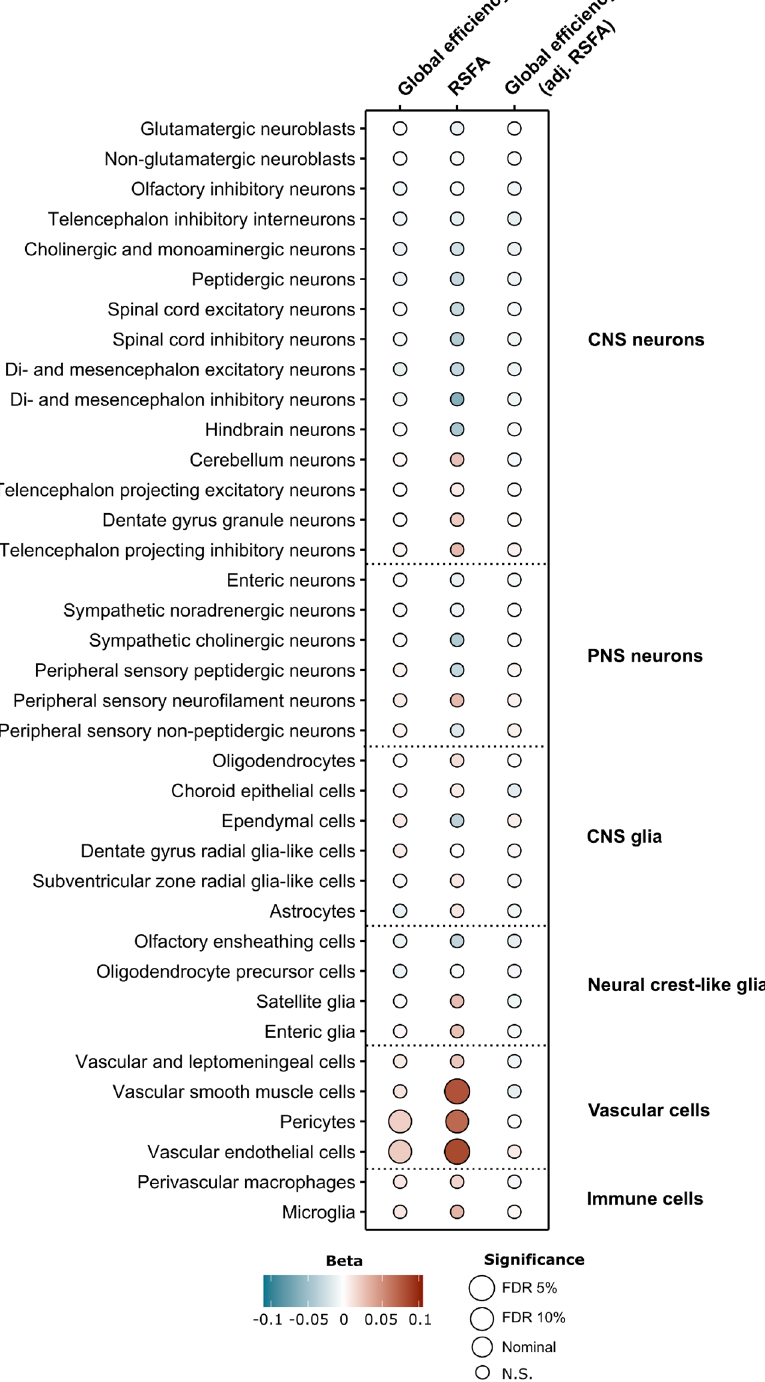
found have potential links with cardiovascular physiology or outcomes. Consistent with this single-cell RNA specificity analyses revealed enrichment of vascular related cells, including pericytes, vascular endothelial cells, and vascular smooth muscle cells for genes associated with average RSFA.